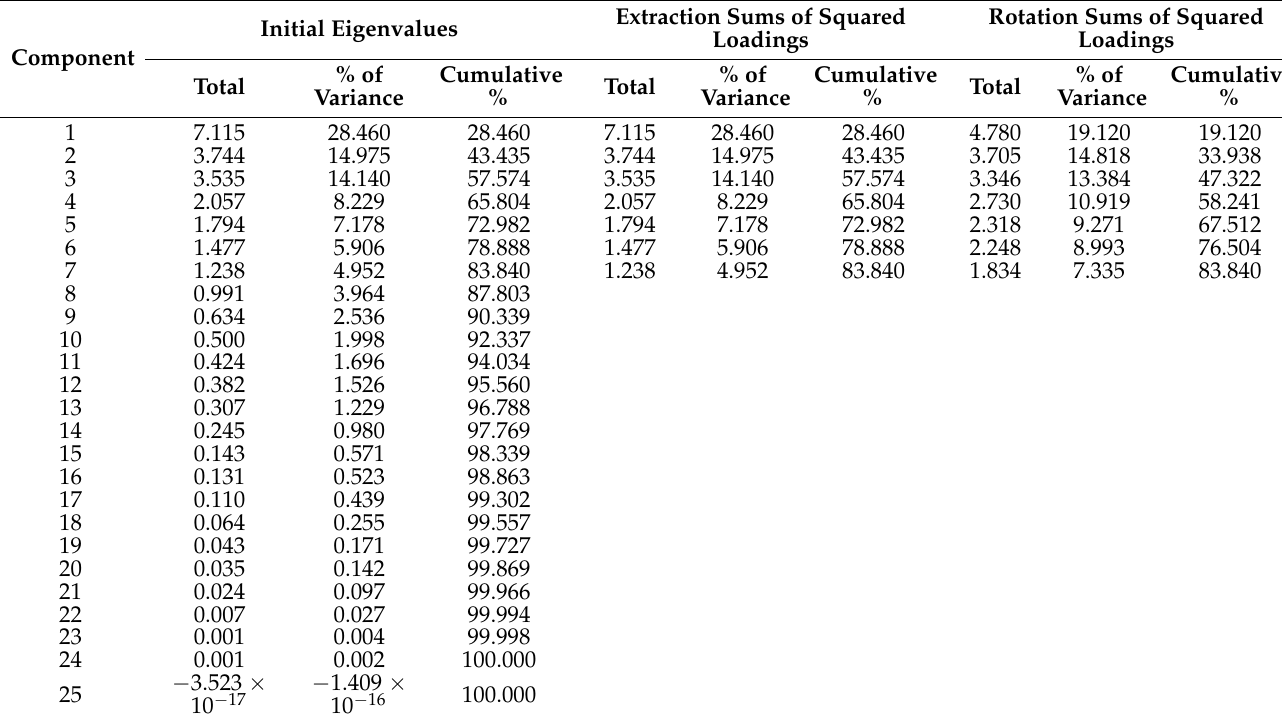
Table 5. Total variance explained.